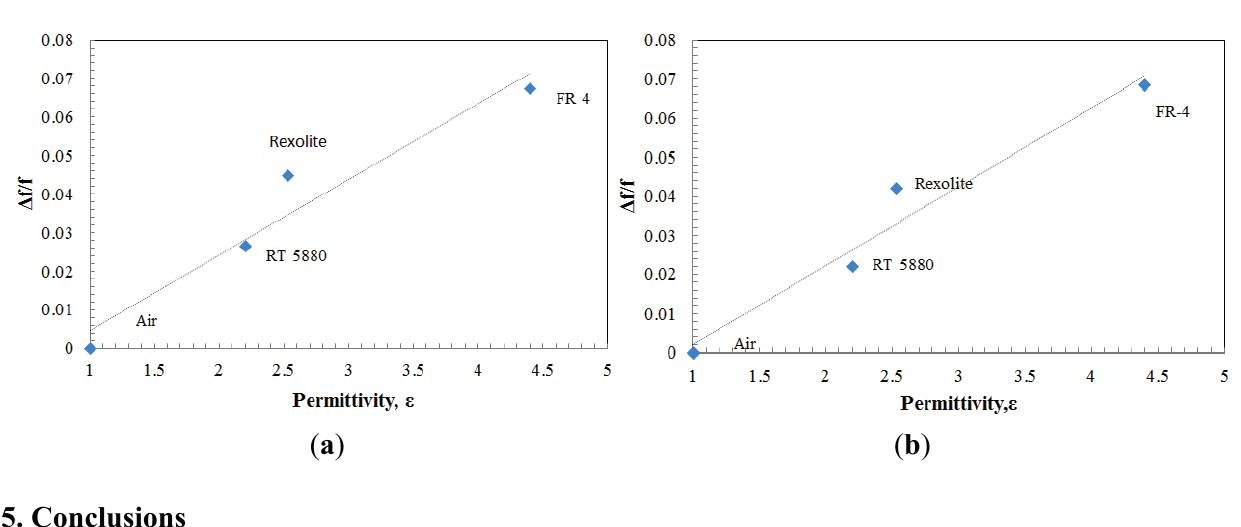
) versus sample permittivity for ( a ) aligned-gap multi-ring; 0